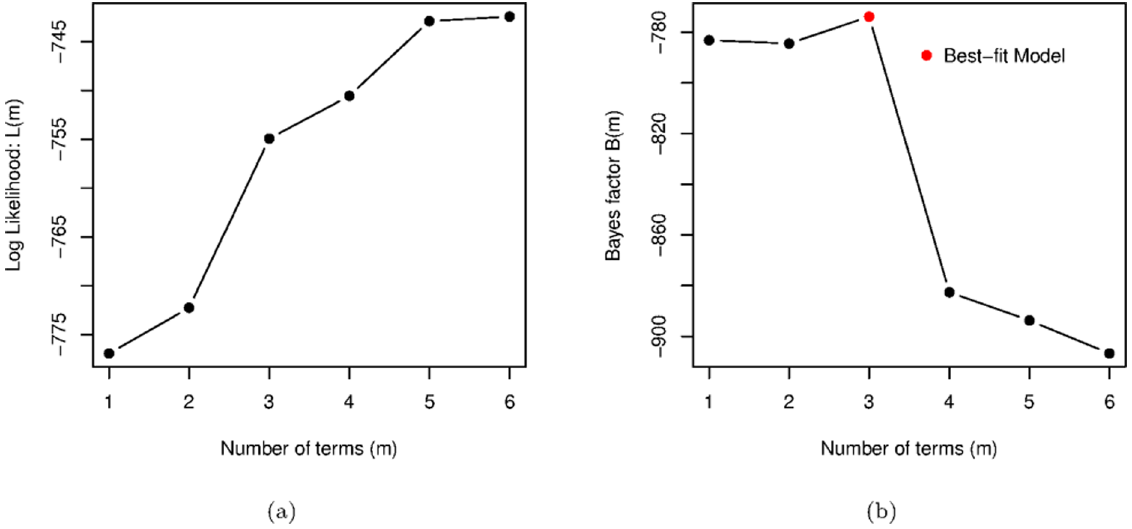
Figure 4. Changes in GDP per capita models. (a) The Log Likelihoods and (b) Bayes Factors for the same models.